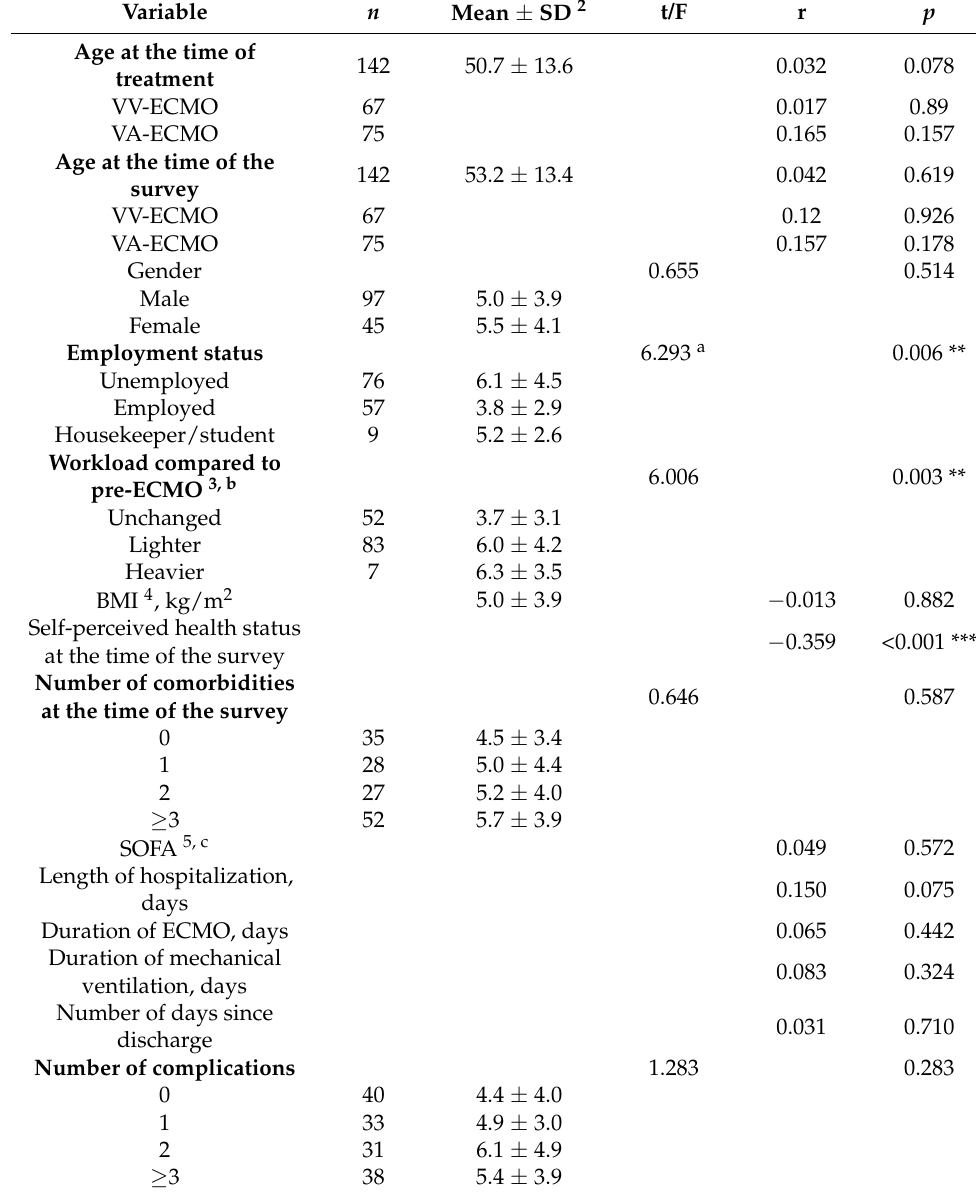
Table 2. The relationship between the characteristics of all participants ( N = 142) and HADS-D 1 depression scores after hospital